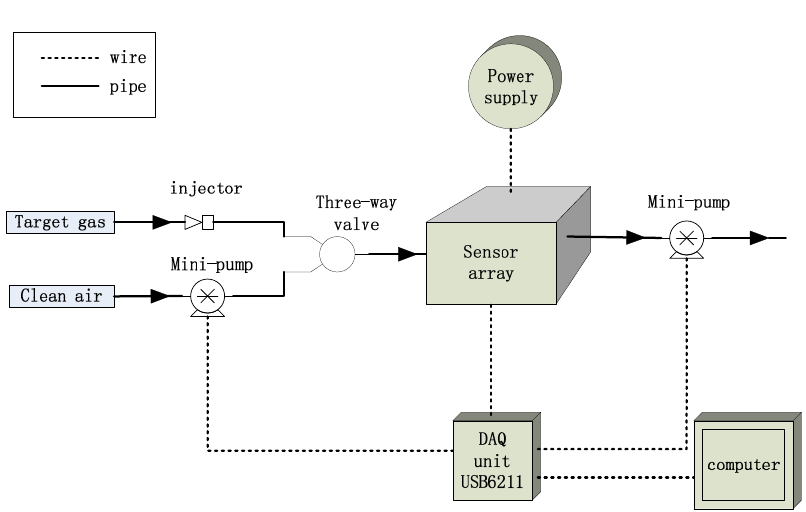
Figure 1. The schematics of the E-nose system.